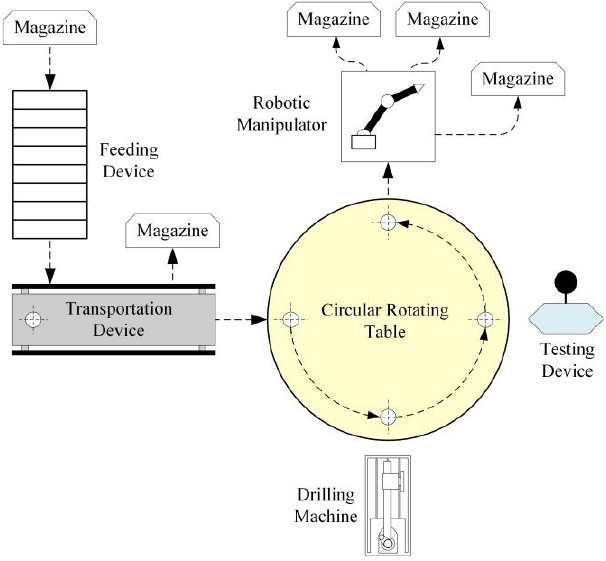
Figure 1. The manufacturing cell.